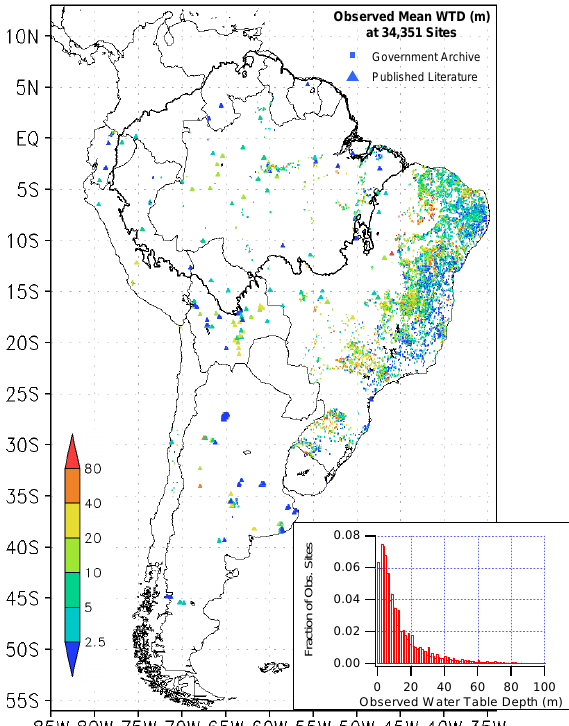
Fig. 1. Observations of water table depth, WTD (m), compiled from government archives and published literature, with the outline of Amazonia ecosystem (inset gives the histogram of WTD).